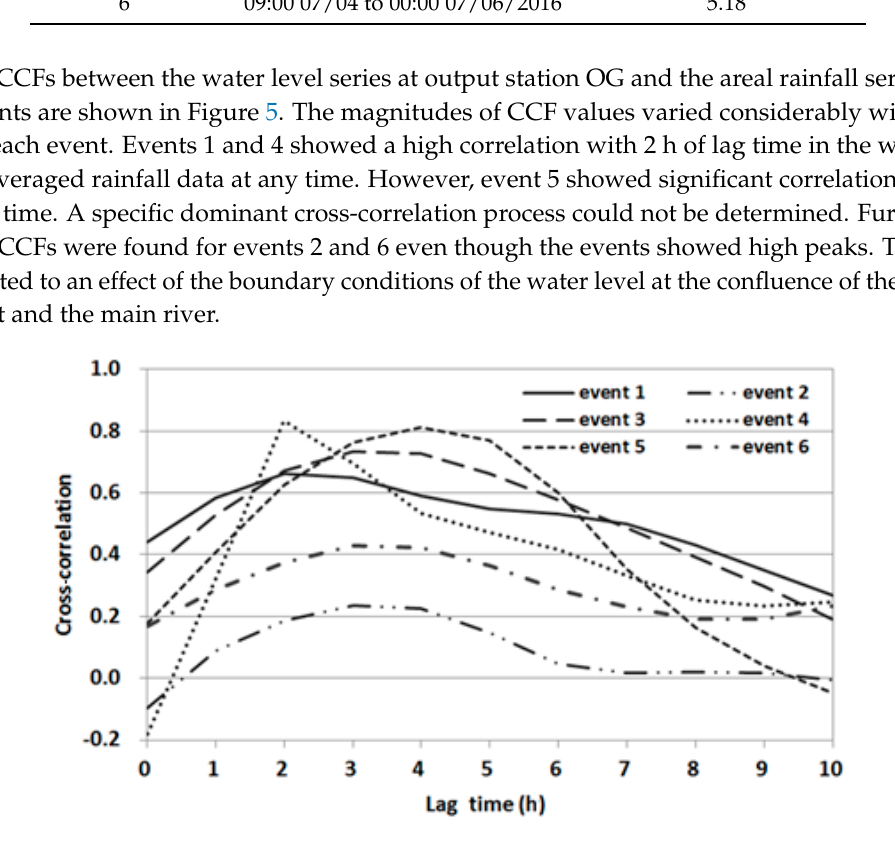
Figure 5. Cross-correlation between water level at Ogeumgyo station (OG) and averaged rainfall series.